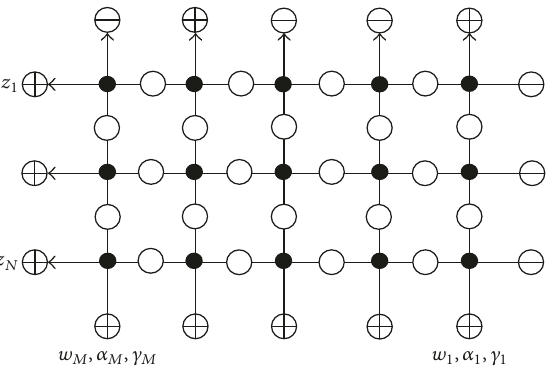
Figure3:Theprojectedwavefunctions 𝑊 𝑀,𝑁 (𝑧 1 ,...,𝑧 𝑁 | 𝑤 1 ,...,𝑤 𝑀 |